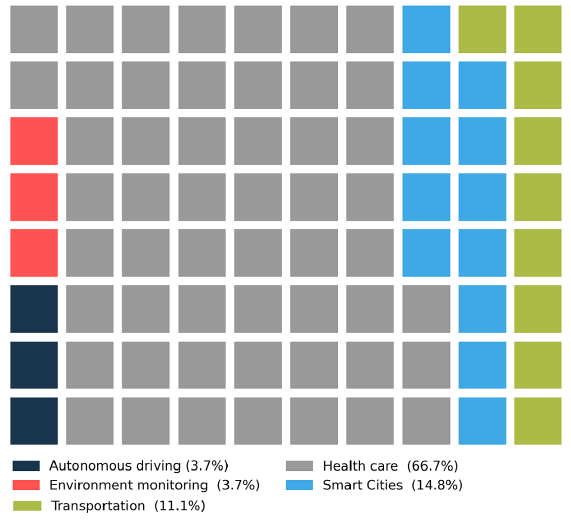
Figure 14. The relationship between HAR and top five most studied application domains.